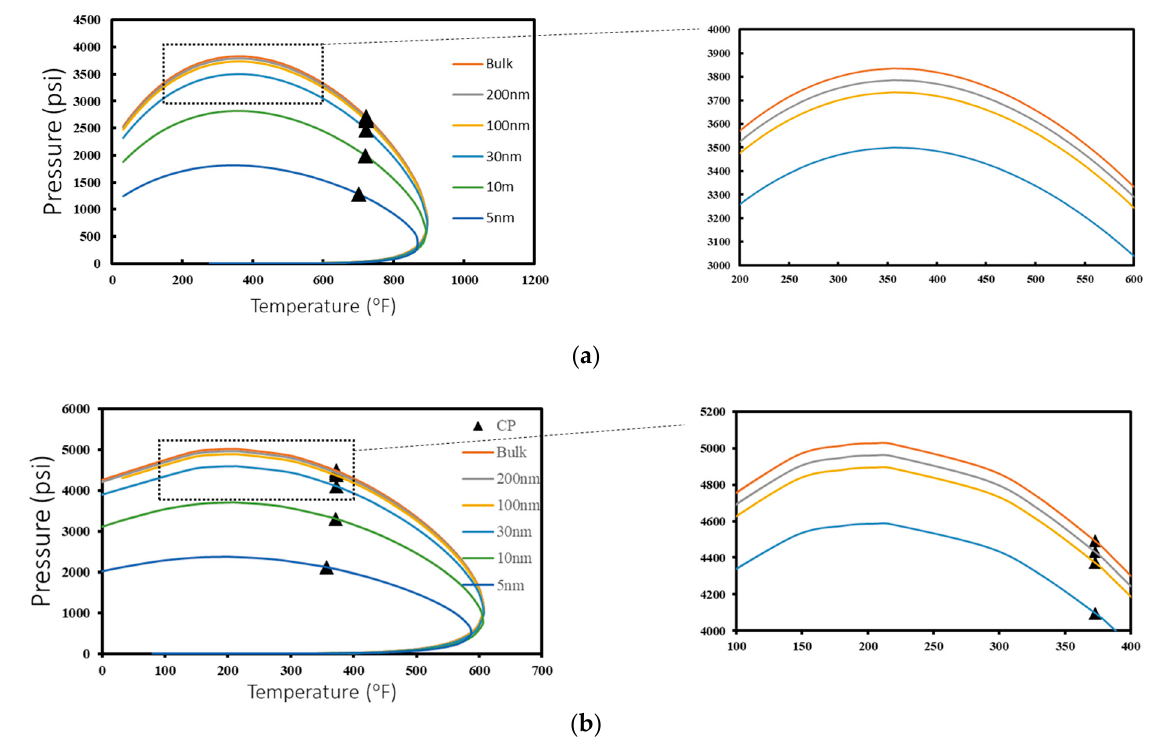
Figure 13. Pressure changes with respect to temperature for different pore sizes for ( a ) Sample 2, ( b ) Sample 3.